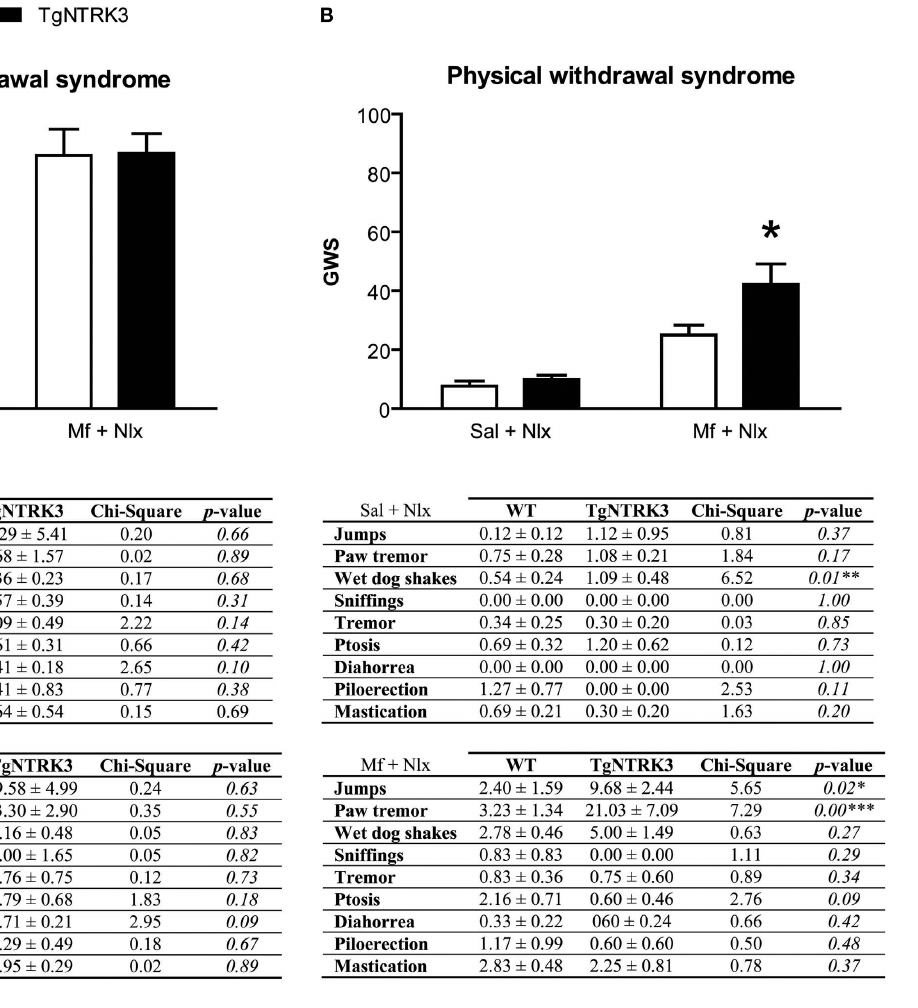
immediately after naloxone administration. The global withdrawal score was calculated for each animal by giving a relative weight to each withdrawal sign (see Materials and Methods). Data are expressed as means ± SEM. Sal: Control saline-treated animals. Tables represent the scores of the physical withdrawal